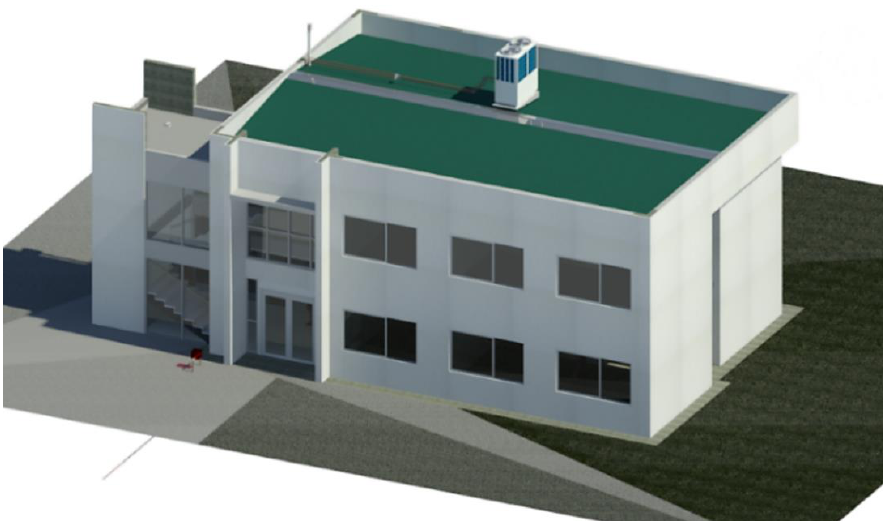
Figure 2. Classroom building model in Autodesk Revit.